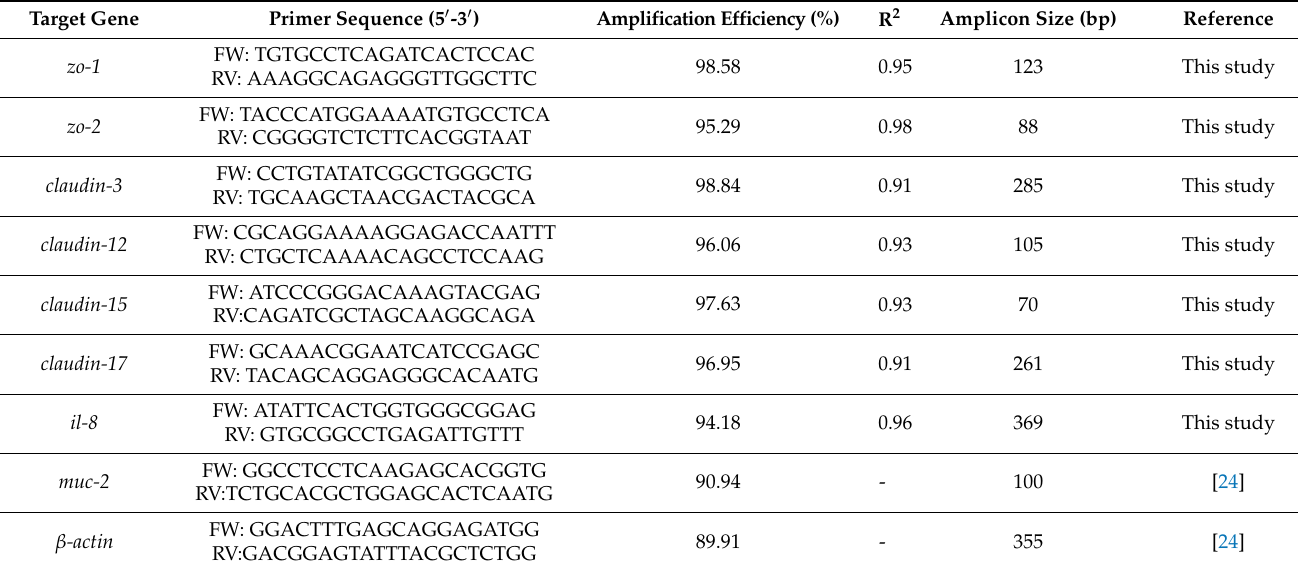
Table 2. Primers used for qPCR